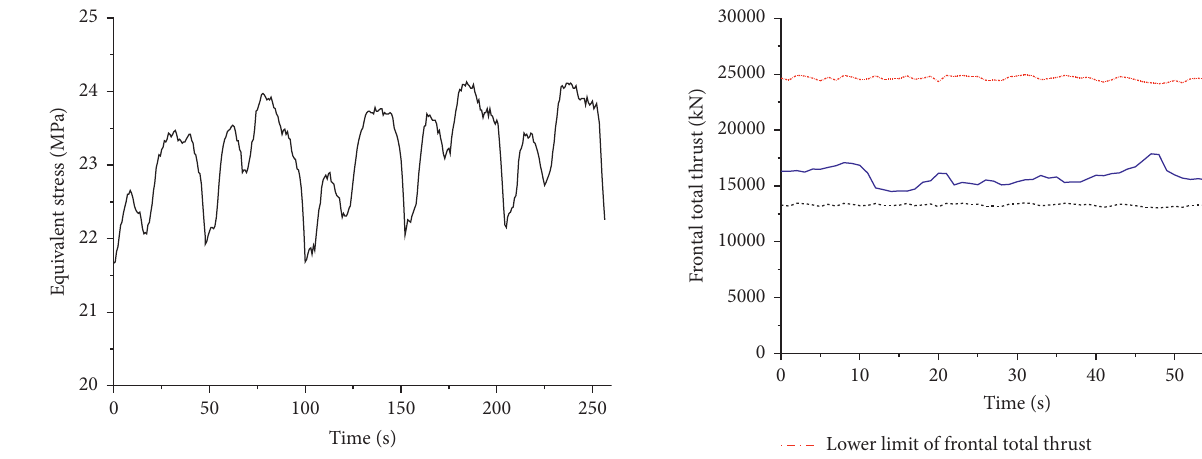
Figure 21: Local equivalent stress curve.